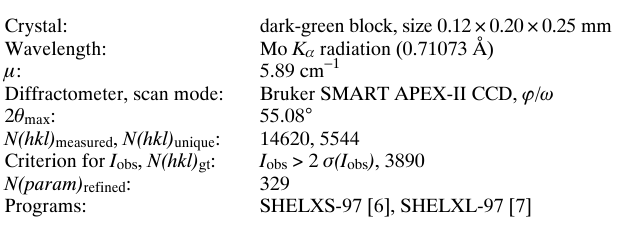
Table 1. D a t a collection a nd h a